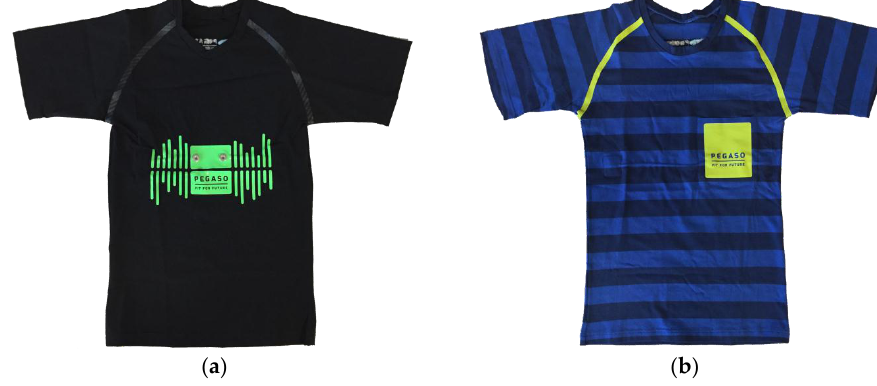
Figure 3. The comparison of the two male versions of the first set of sensorized t-shirts: ( a ) the style with technical textile and the visible device to be attached to the two snap buttons; ( b ) the style with a more fashionable colour and the sensing device hidden into the pocket where the two connecting snap buttons are placed.